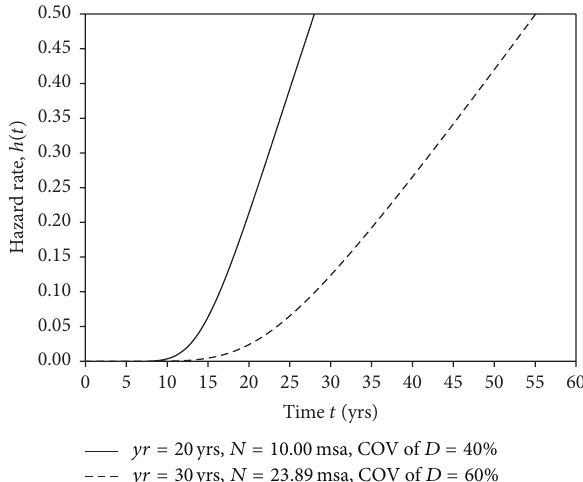
Figure 3: Comparison of reliability and survival functions for fatigue and rutting